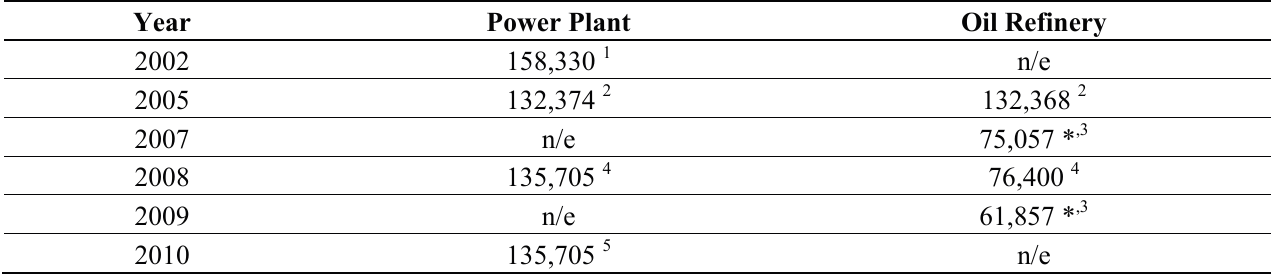
(tons/year) from the Tula 2